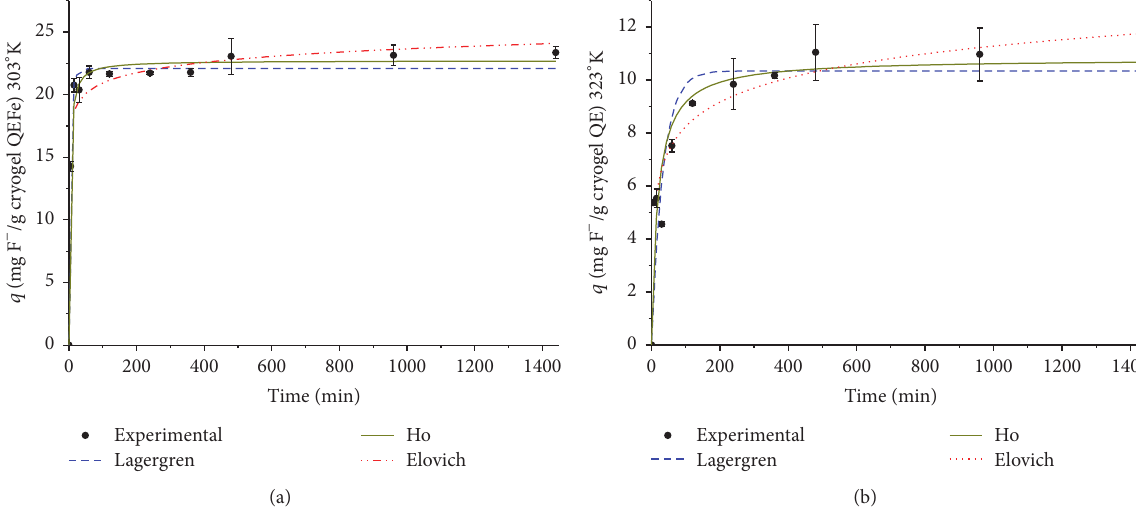
Figure 11: Adjustment to kinetics models, 8 mL of 10 mgL −1 , 200 rpm, 0.002 g cryogel mass, pH 6, closed atmosphere: (a) cryogel QEFe 303 K; (b) cryogel QE 323